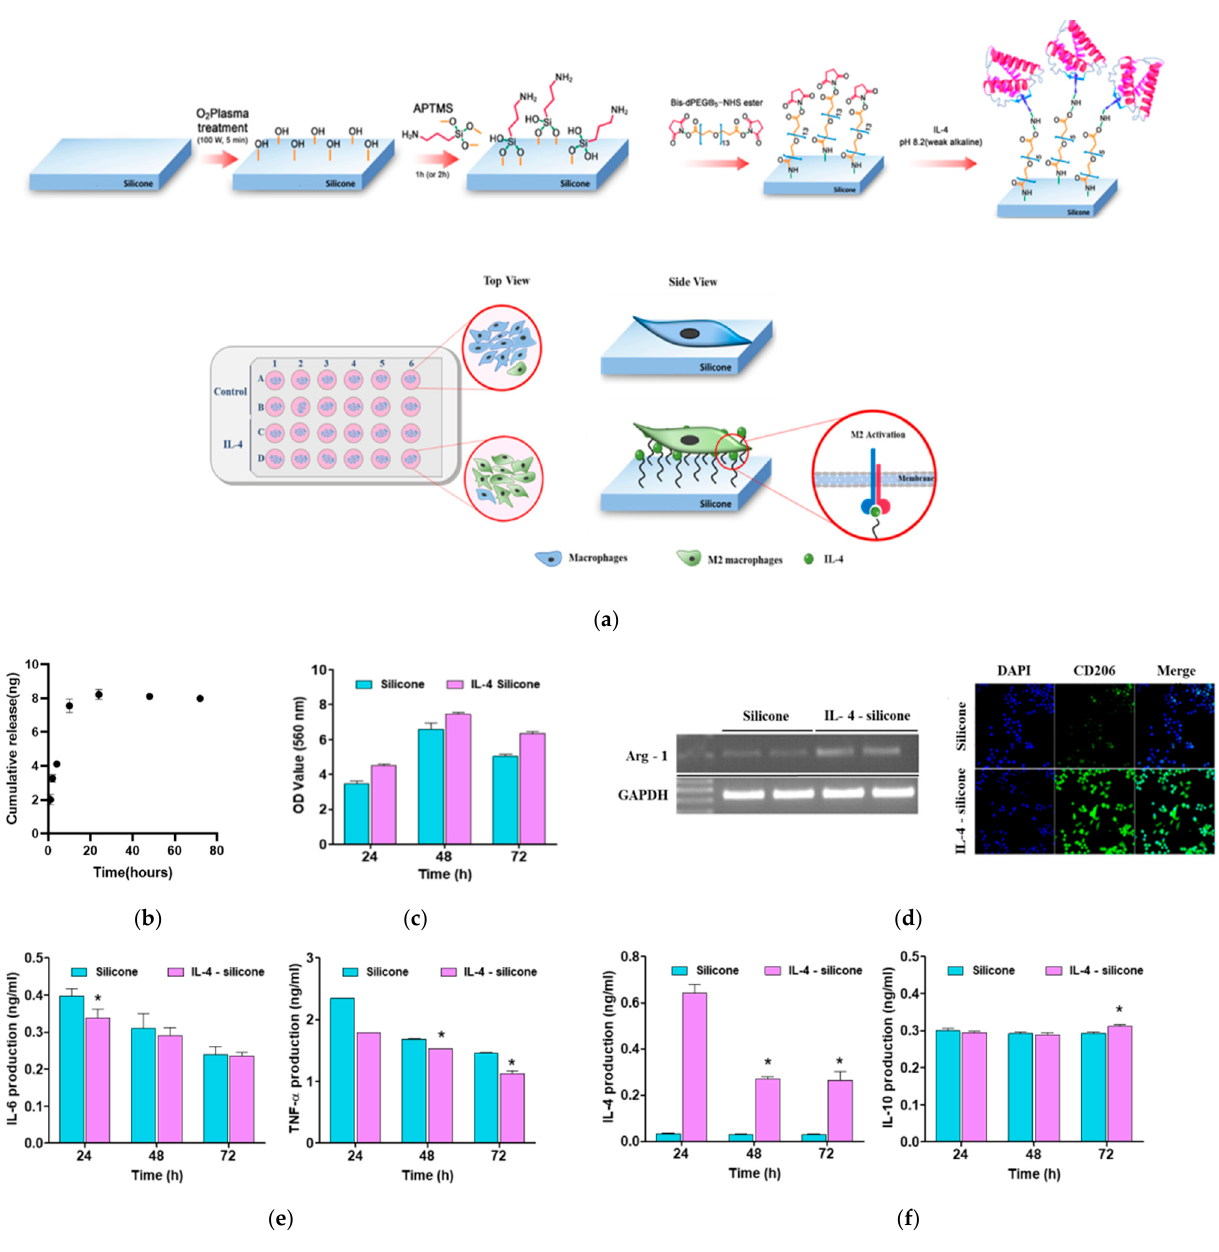
Figure 3. The effect of a silicone implant coated with IL-4 on macrophage polarization and the IL-4 release pattern in in vitro studies. ( a ) A schematic diagram of the in vitro cell culture system with IL-4-coated silicone implants. Raw 264.7 cells were cultured on the surfaces of silicone implants with or without IL-4 for 72 h. ( b ) IL-4 released from the silicone implant was evaluated at different time intervals. ( c ) MTT assay of silicone and IL-4-coated silicone. ( d ) Arg-1 expression on both implants and CD206 expression on the implants were assessed by confocal microscopy. ( e ) The production of pro- inflammatory cytokines (IL-6 and TNF- α ). ( f ) Anti-inflammatory cytokines (IL-4 and IL-10) was determined by the ELISA method. The data are expressed as mean ± SD and show significantly (* p < 0.05; one-way ANOVA) different values from the bare silicone implant